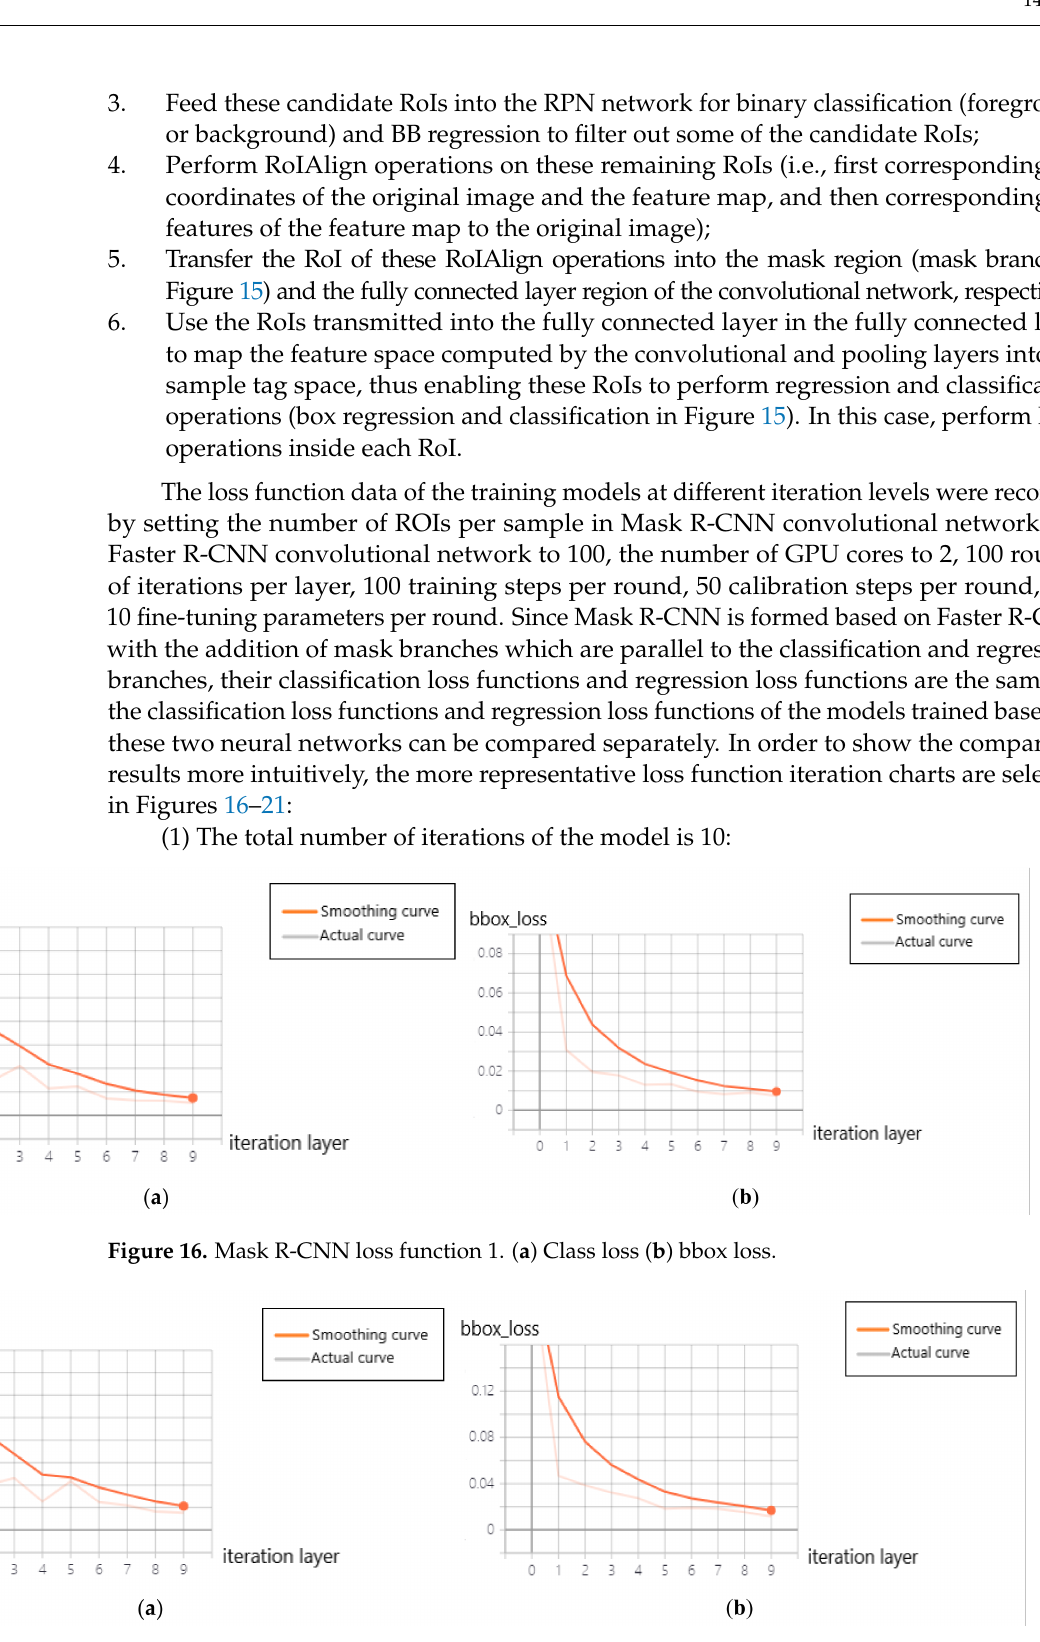
Figure 17. Faster R-CNN loss function 1. ( a ) Class loss, ( b ) bbox loss. (2) The total number of iterations of the model is